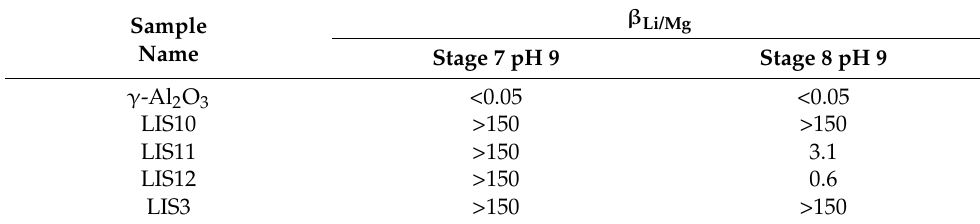
Table 4. Selectivity factor β between Li + and Mg 2+